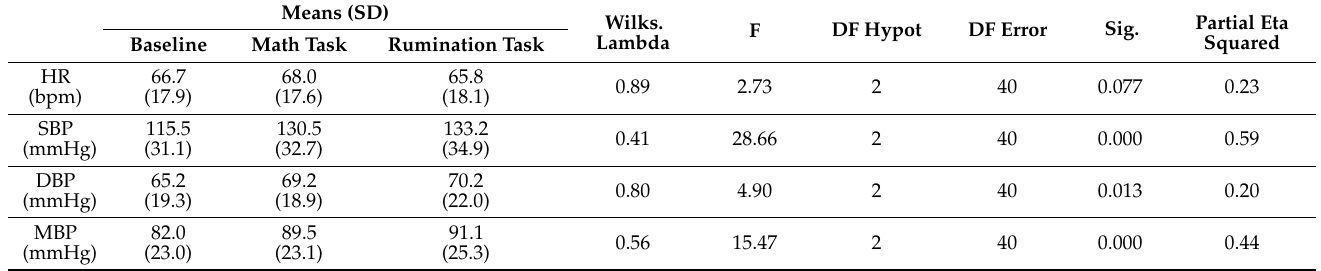
Table 1. One-way repeated measures ANOVAs in heart rate, systolic blood pressure, diastolic blood pressure and mean blood pressure means between baseline, math task ( n = 42) and rumination task ( n = 34)